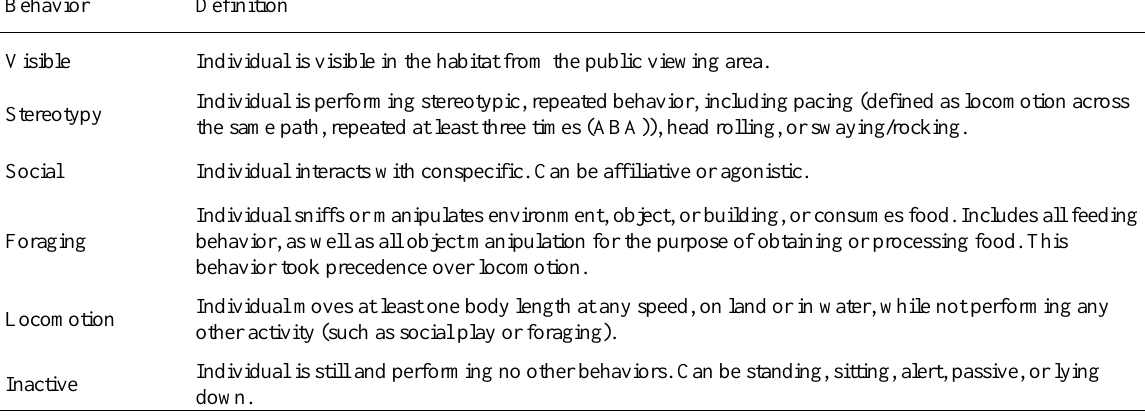
Behavioral Ethogram Used to Collect Bear Behavior